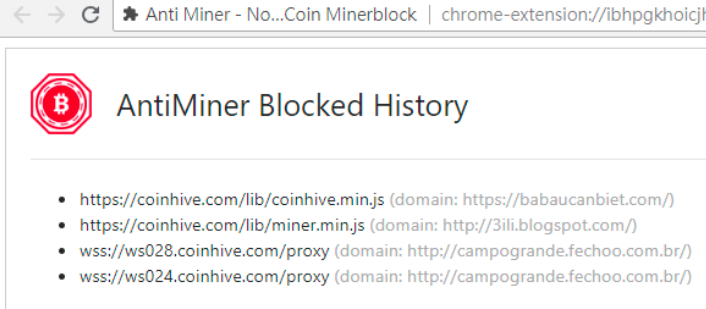
Figure 6. AntiMiner blocked history.